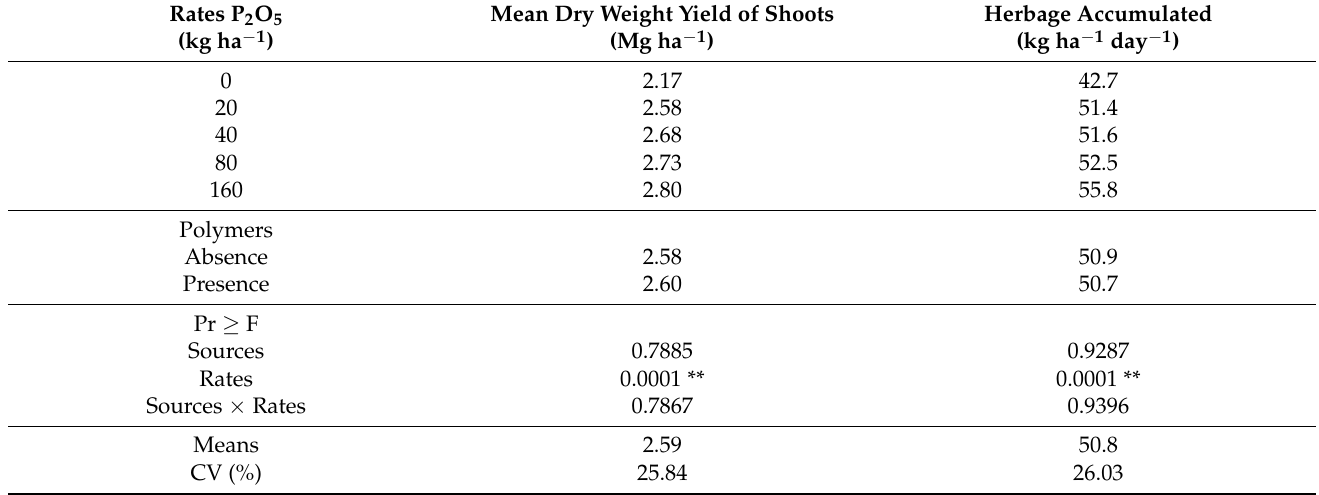
Table 2. Mean dry weight yield of shoots per evaluation and herbage accumulated per hectare per day of Mavuno grass for different phosphorus sources and rates, in the presence and absence of polymers in dystrophic Ultisol.